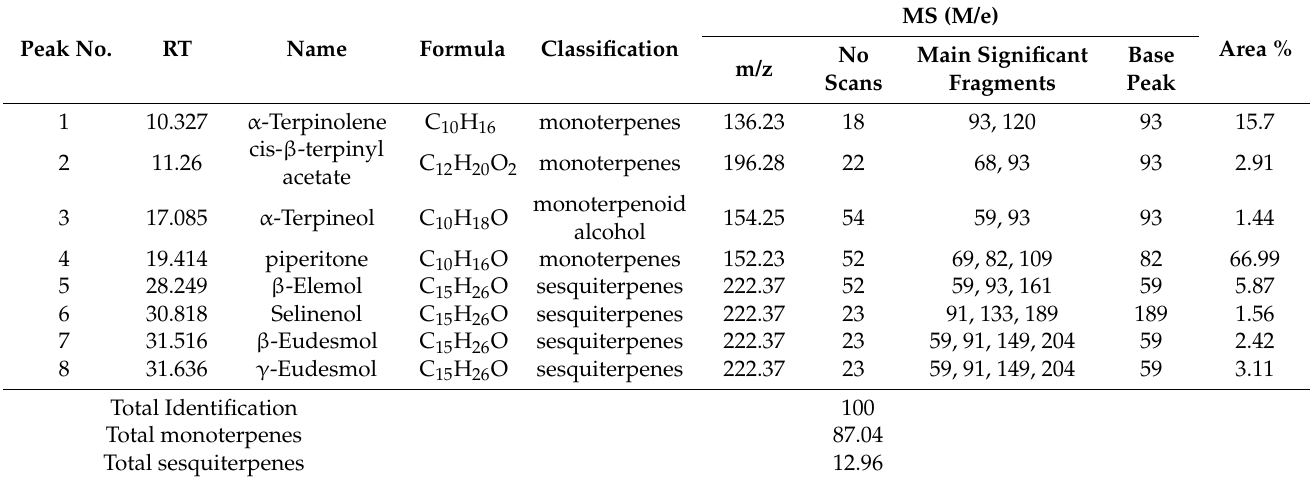
Table 2. The main constituents of Cymbopogon proximus